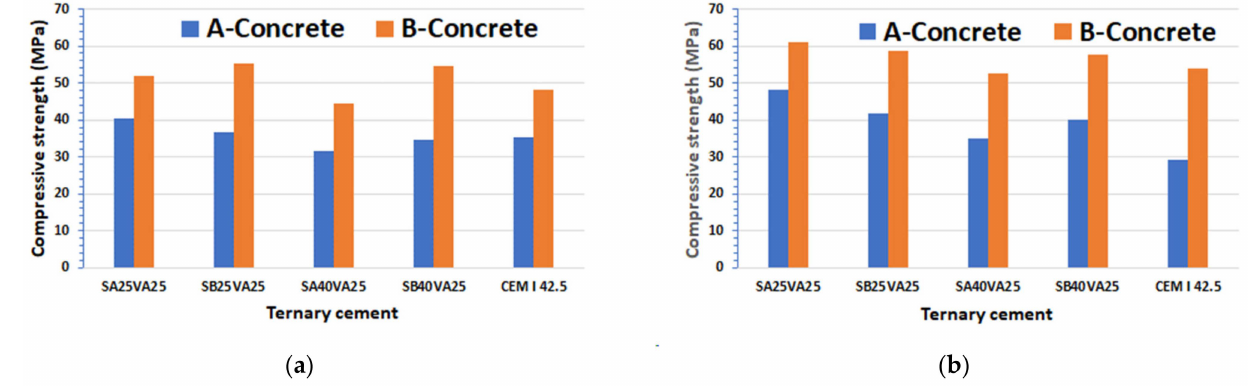
Figure 3. A-Concrete and B-Concrete compressive strength (MPa): ( a ) at 28-days; ( b ) at 90-days.